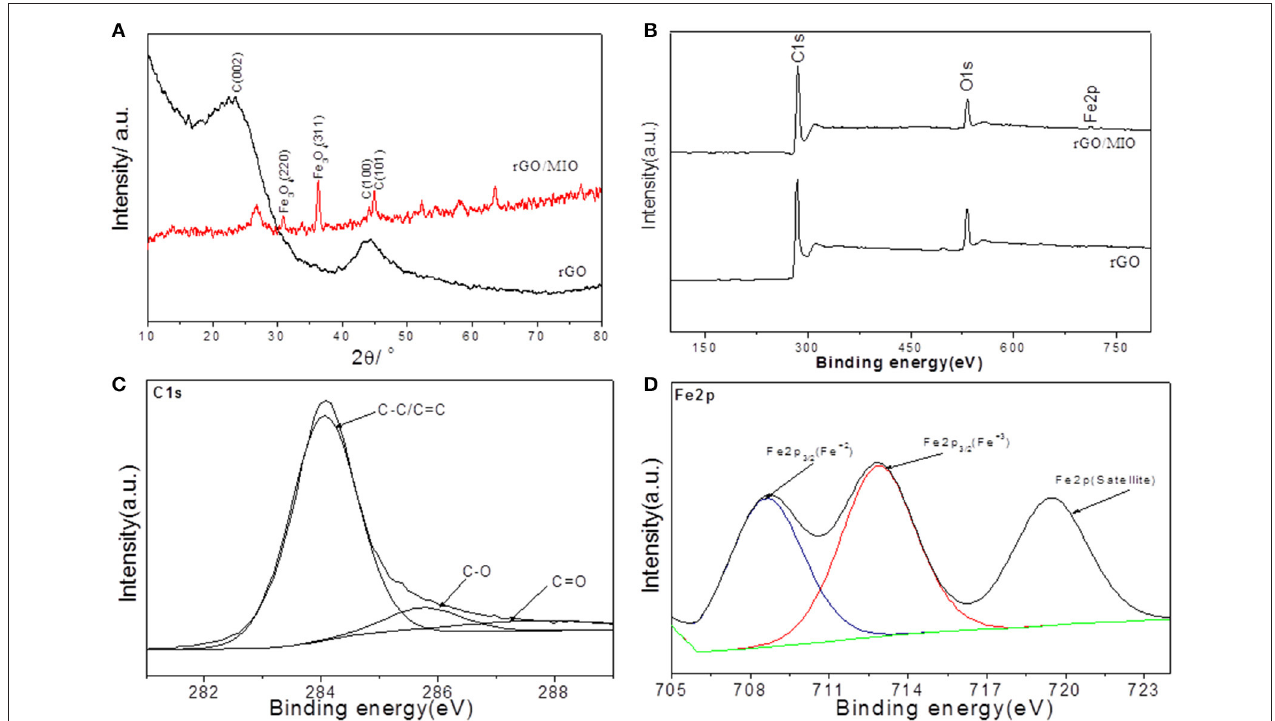
FIGURE 3 | (A) XRD patterns and (B) XPS survey spectra for rGO and rGO/MIO nanocomposite, together with high-resolution spectra of (C) C1s (D) Fe2p of rGO/MIO